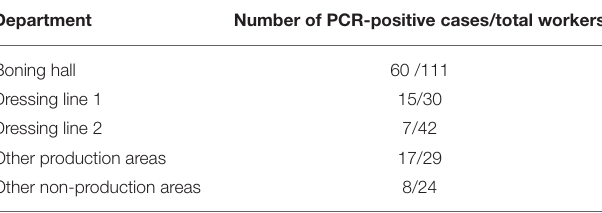
Frontiers in Public Health |